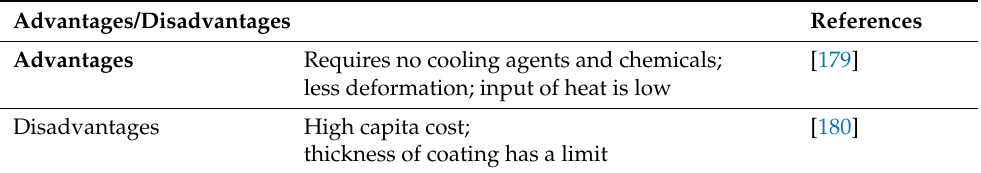
Table 10. Some of the significant advantages and disadvantages of laser treatment are mentioned in this